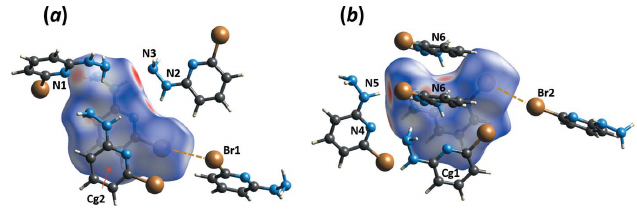
Figure 3 Views of the Hirshfeld surface for ( a ) molecule ( I2 ) and ( b ) molecule ( I1 ), mapped over d norm in the range (cid:5) 0.56 to 0.97 a.u. with the blue-to-red color palette reflecting distances from a point on the surface to the closest nuclei. The neighboring molecules involved in the shortest N—H (cid:2)(cid:2)(cid:2) N hydrogen bonds, the Br (cid:2)(cid:2)(cid:2) Br halogen bond, and the Cg (cid:2)(cid:2)(cid:2) Cg stacking interactions are